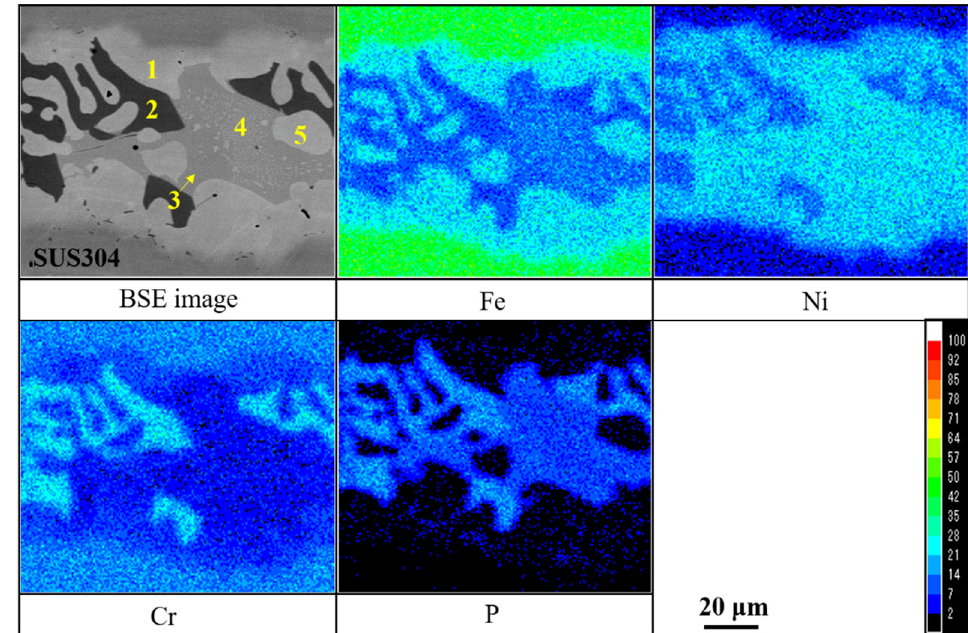
Figure 6. Mapping analysis results for cross section of joint brazed with electrodeposited Ni-13.4Cr- 11.6P alloy coating. Table 3. Chemical compositions of each phase shown in BSE image in Figure 6.